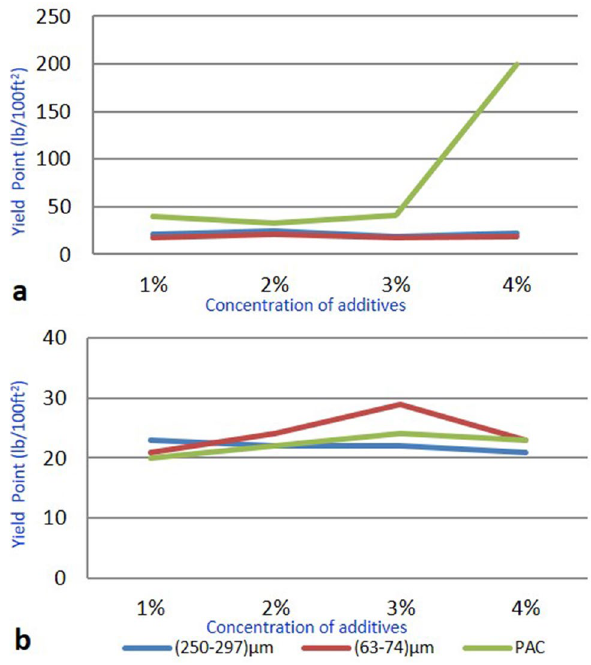
Fig. 8 Yield Strength comparison of developed drilling fluids formu- lations a before hot roll, b after hot